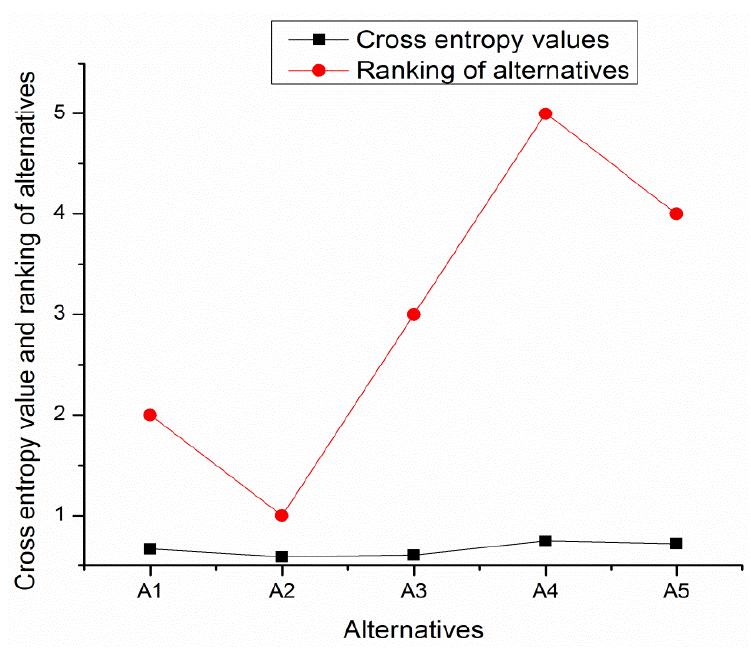
Figure 3. Graphical representation of cross entropy values and ranking of alternatives.